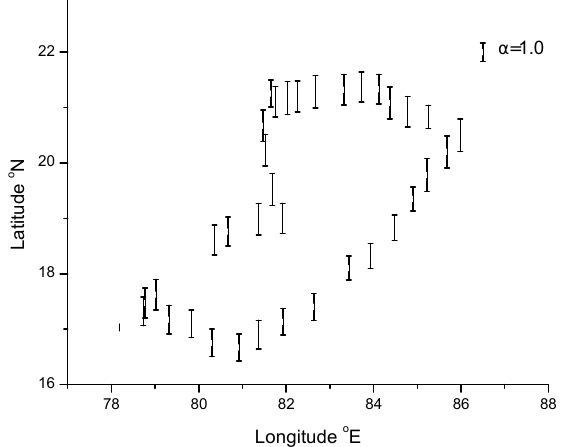
Fig. 5. ˚Angstr¨om parameter at α gt various observational sites de- rived from aerosol spectral optical depths.